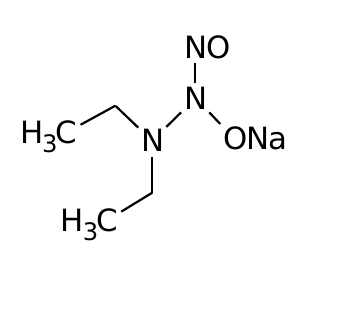
Figure 2. Chemical structure of